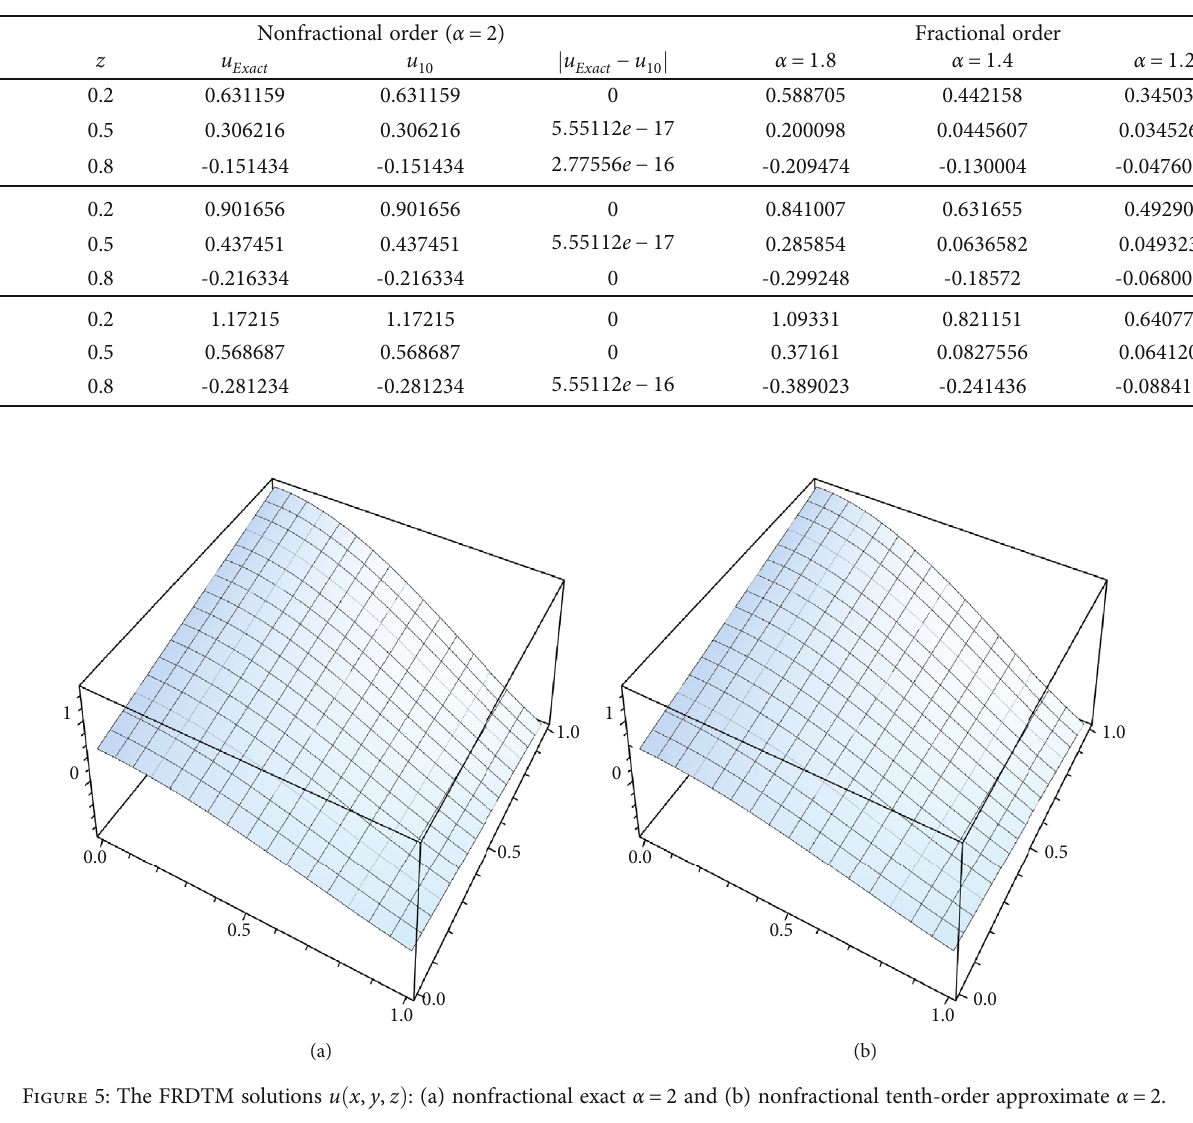
Table 3: Exact solution of nonfractional order and tenth-order approximate solutions by